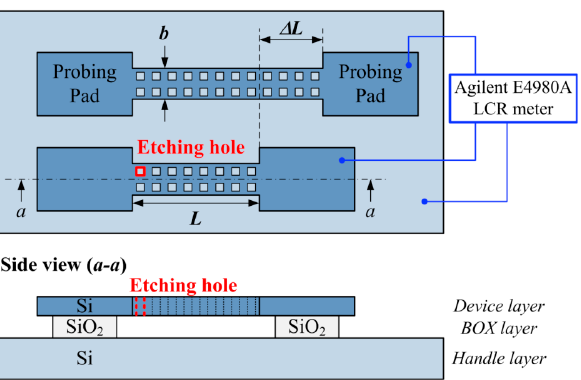
Figure 10. The schematic of test microstructures. L : length of the test beam.